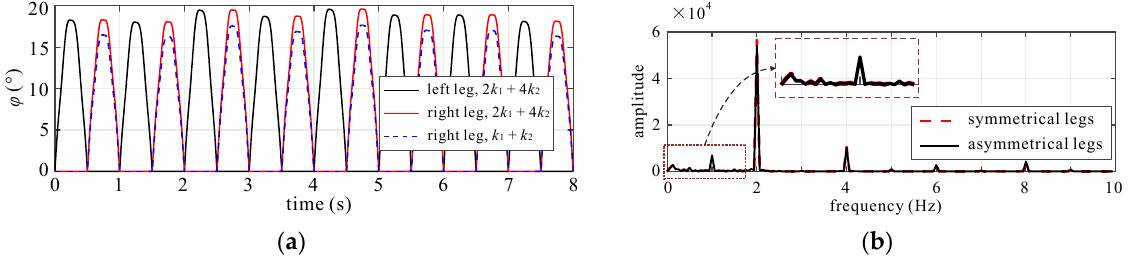
Figure 13. Simulation results regarding the legs’ asymmetry: ( a ) Values of φ 3 of the two legs with different stiffness (stance phase); ( b ) FFT analysis of the robot’s pitch motion.